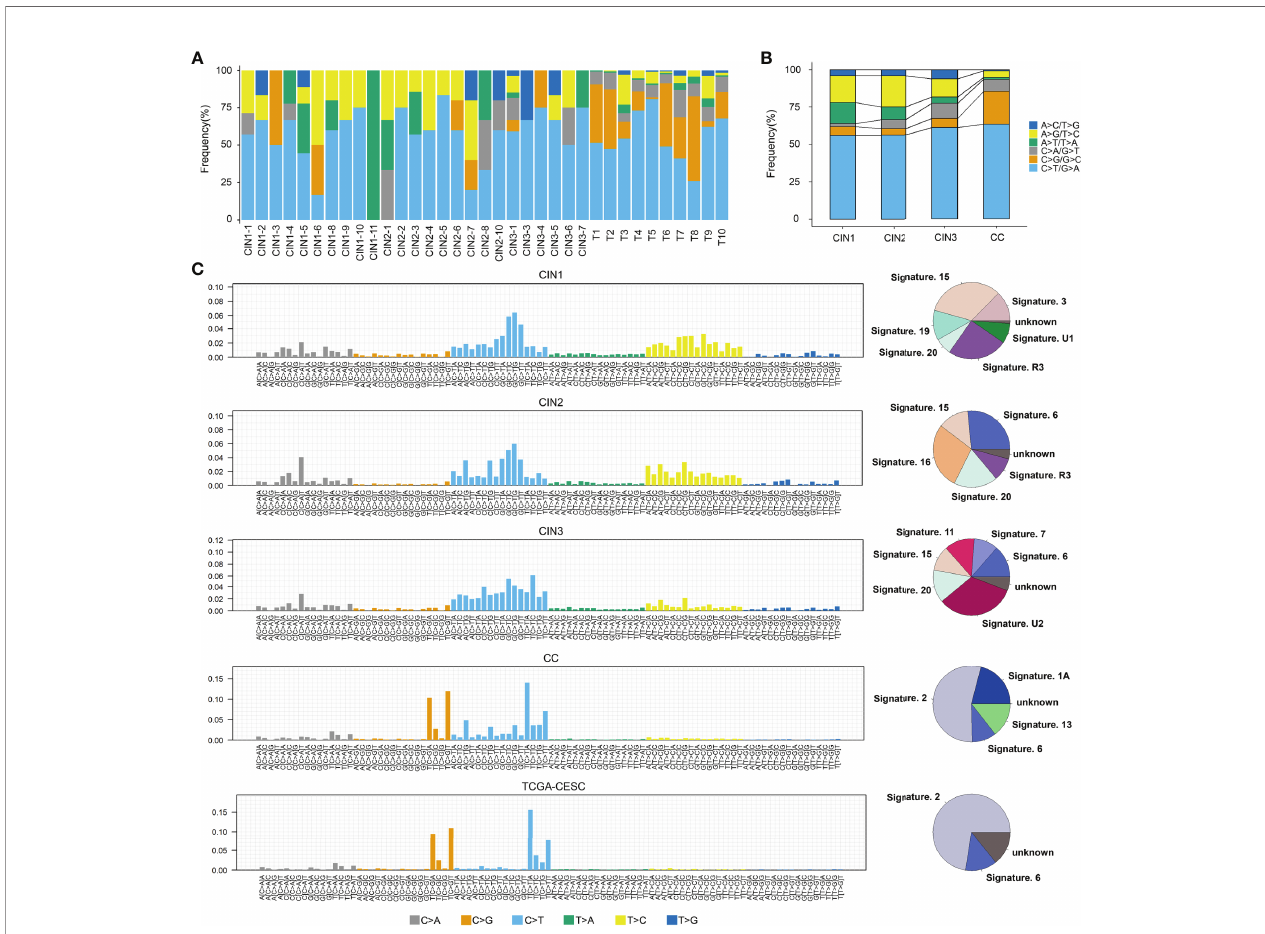
FIGURE 3 | The mutation spectrums and mutational signatures in CINs and CCs. (A) Mutation substitution types identi fi ed the 6 substitutions classi fi cation on the basis of the nucleotide frequency of the human genome among all samples. The horizontal axes indicated the cervical neoplasia patients ID, and the vertical axes depicted the percentage of mutations categories to a speci fi c mutation type. C>T/G>A transitions were predominant across most of cervical neoplasia patients. The horizontal axis indicated the sample ID, and the ordinate corresponds to the number of mutation types. (B) The trend of each nucleotide substitution subtype in CIN1, CIN2, CIN3, and CCs. (C) Mutational signatures in CIN1, CIN2, CIN3, CC, and TCGA-CESC, receptively. Proportion of mutation signatures distribution in each group (on the left). Inset pie chart shows the proportion of mutation signatures in each group (on the